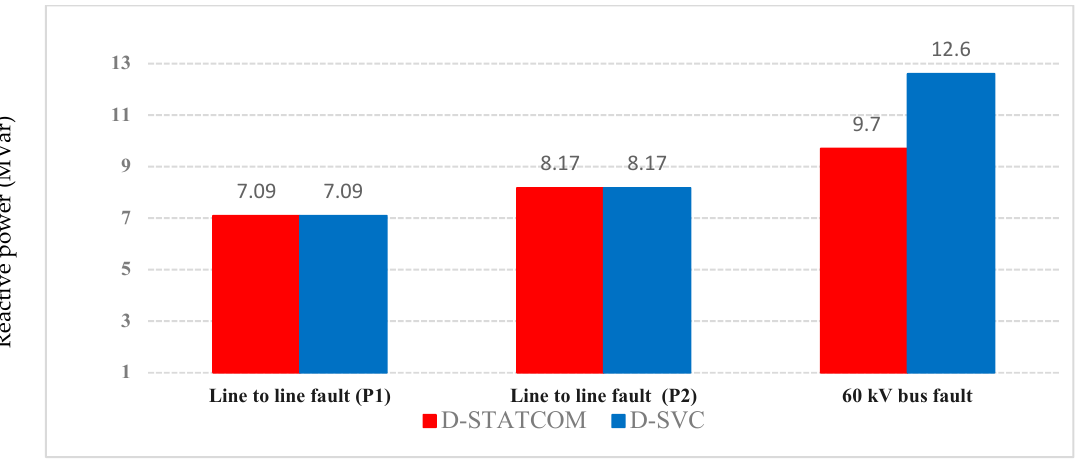
Figure 20. Reactive power injected into the PCC by using D-SVC and D-STATCOM with different types of grid faults.